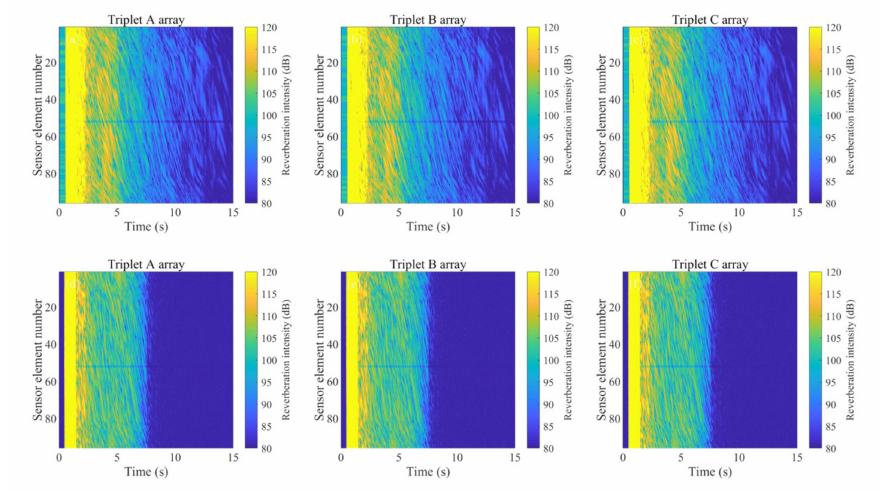
Figure 6. Two examples of the measured CW reverberation intensity for the time and sensors of each line array in the triplet line array. The upper figures are the results of ping 107 ( z s = 127 m and z r = 117 m) and the lower figures are those of ping 669 ( z s = 36 m and z r = 72